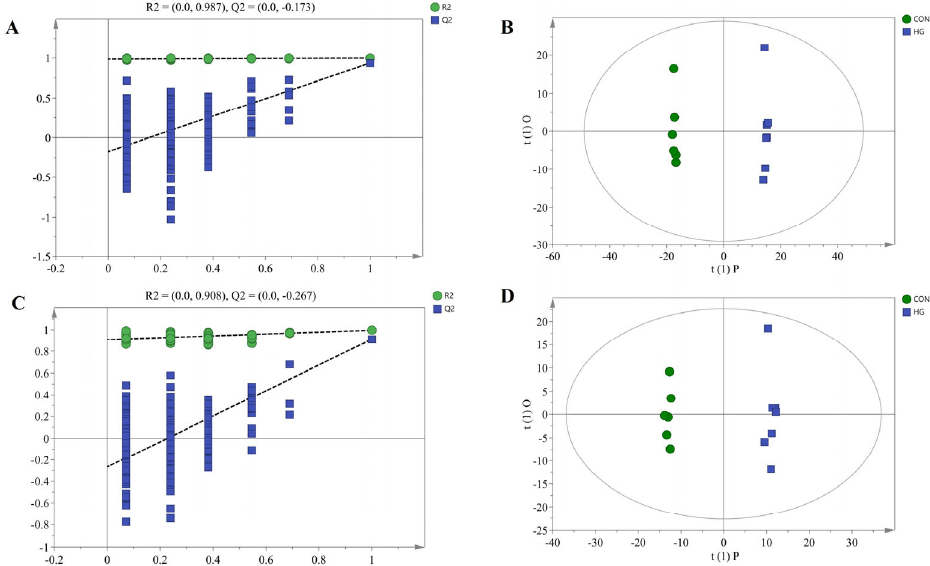
Figure 4. Corresponding validation plots and OPLS-DA score plots of yak rumen metabolites in the CON and HG groups following ( A , B ) positive and ( C , D ) negative mode ionization.